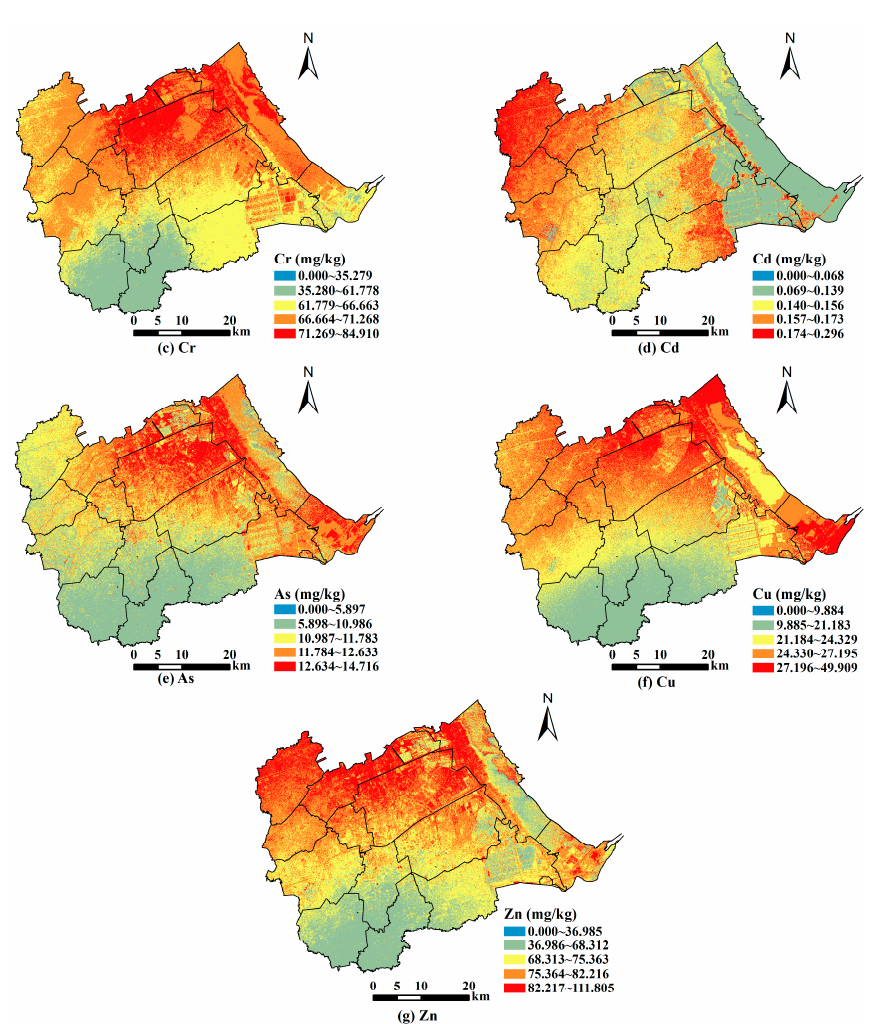
Figure 5. The spatial distribution of heavy metals in Huanghua (( a – g ) correspond to the elements of Ni, Pb, Cr, Cd, As, Cu and Zn, respectively).